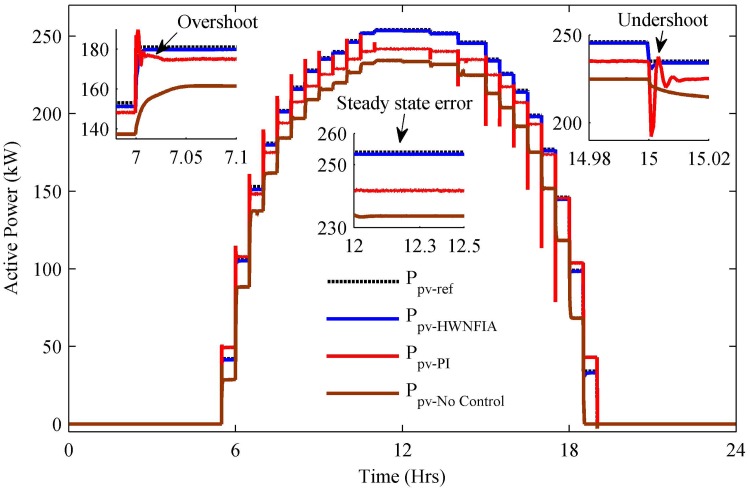
PV output power.